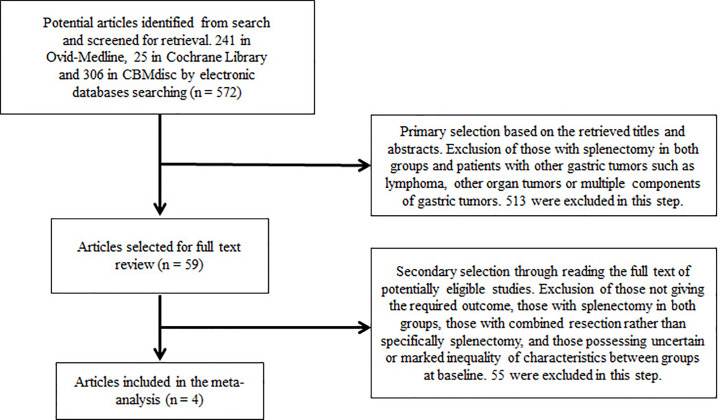
Flow chart showing study selection procedure.